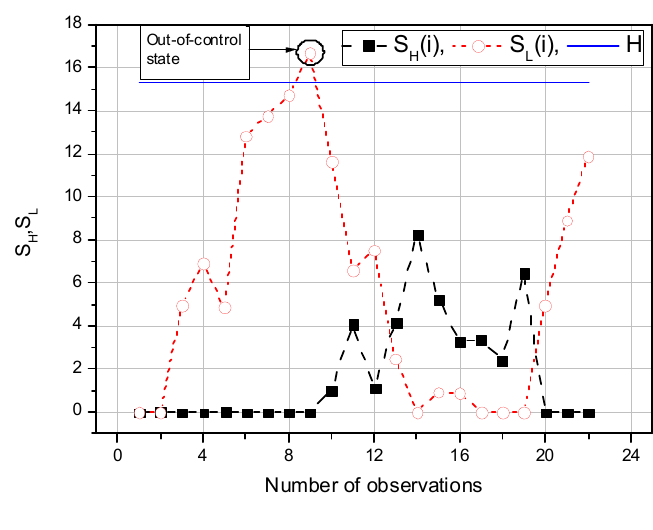
Figure 5. Example of CUSUM